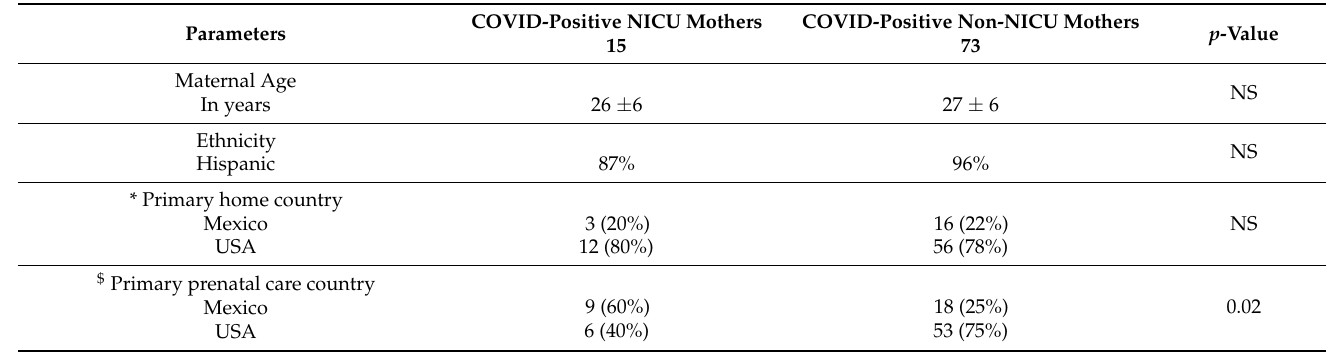
Table 1. Maternal characteristics of SARS-CoV-2-infected mothers of neonates admitted to the NICU and those who were